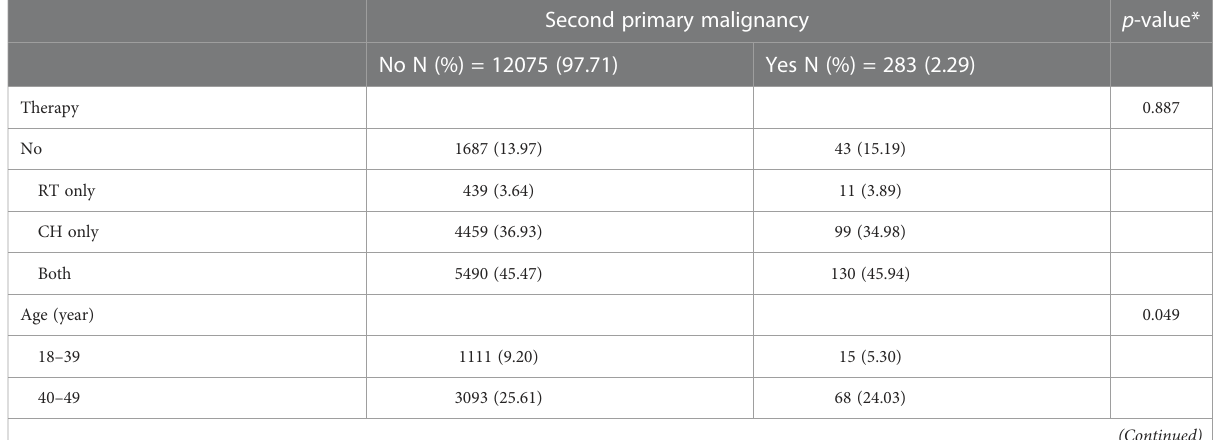
TABLE 4D Risk of second primary malignancies in patients with stage III/IV breast